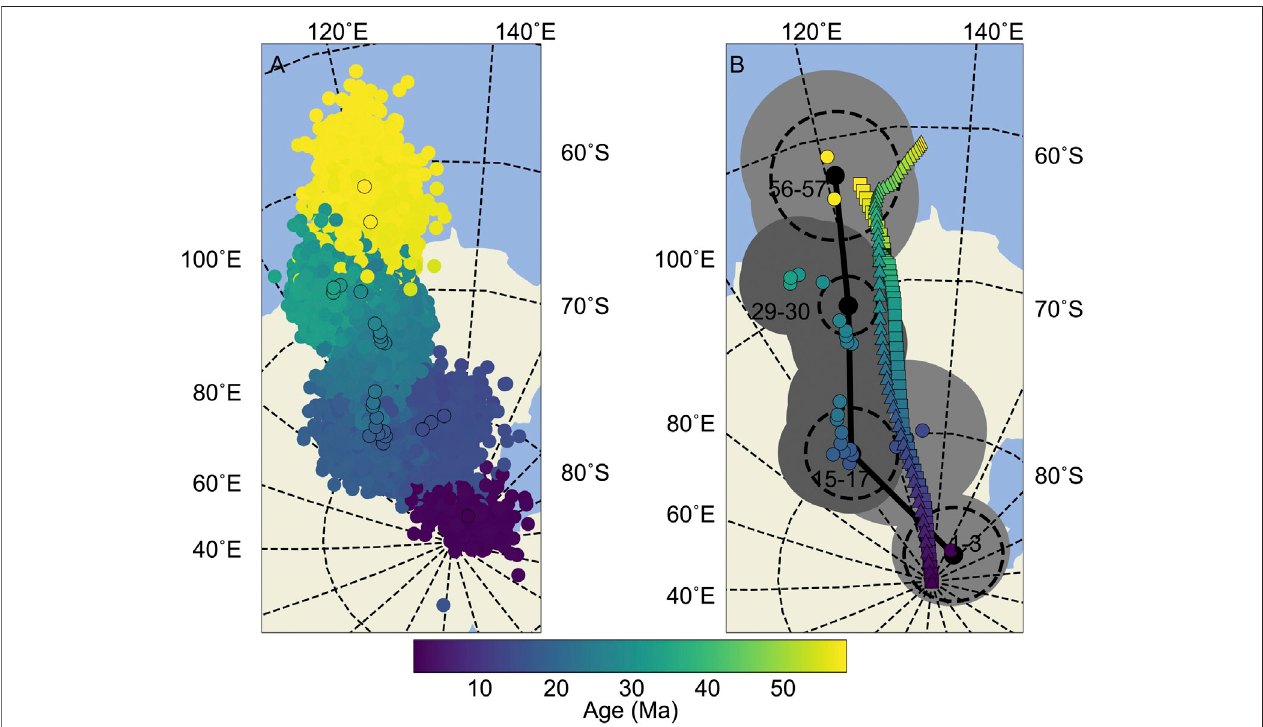
FIGURE 8 | Combined Paleomagnetic Poles for Cenozoic Australia. (A) Clusters of similar colored circles without outlines are bootstrap poles, while outlined are markers indicate the poles found in each 10 Ma search window ( Table 2 ). Discontinuities in poles through time occur over intervals where VGP data are insuf fi cient for pole calculation (e.g., between 2 – 12 Ma). (B) Poles from A. plotted with their A 95 ellipses (in gray, darker gray where hotspot volcanoes are active) plotted together with synthetic APWP paths, indicated by squares (Seton et al., 2012) and triangles (Matthews et al., 2016) as well as conventional APWP construction (ages labeled in Ma) (Hansma and Tohver,